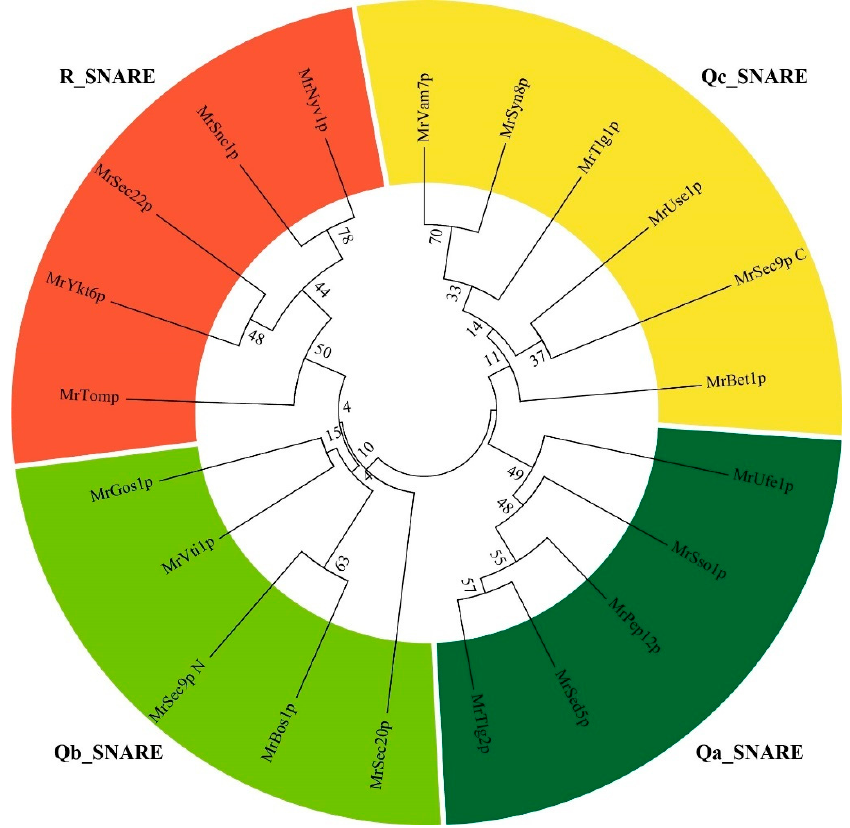
Figure 4. Phylogenetic analysis of 20 SNAREs identified in M. ruber M7. Dark green indicates Qa_SNAREs, light green indicates Qb_SNAREs, yellow indicates Qc_SNAREs, and red indicates R_SNAREs.